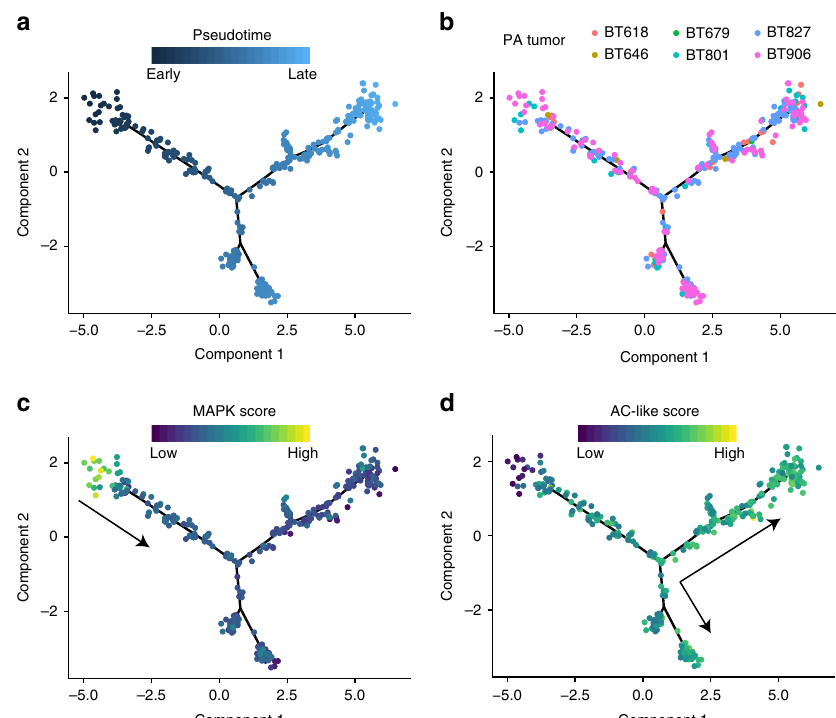
Fig. 7 Inferred trajectories between PA cancer cells. PA cancer cells are plotted based on a lineage trajectory inferred from RNA-seq data. a Cancer cells are colored based on pseudotime inferred from cell trajectory, with pseudotime beginning in the branch on the top right and advancing as cells approach the left and bottom branches. b Cells are colored by tumor of origin. c Cells are colored by MAPK signaling gene programme score. d Cells are colored